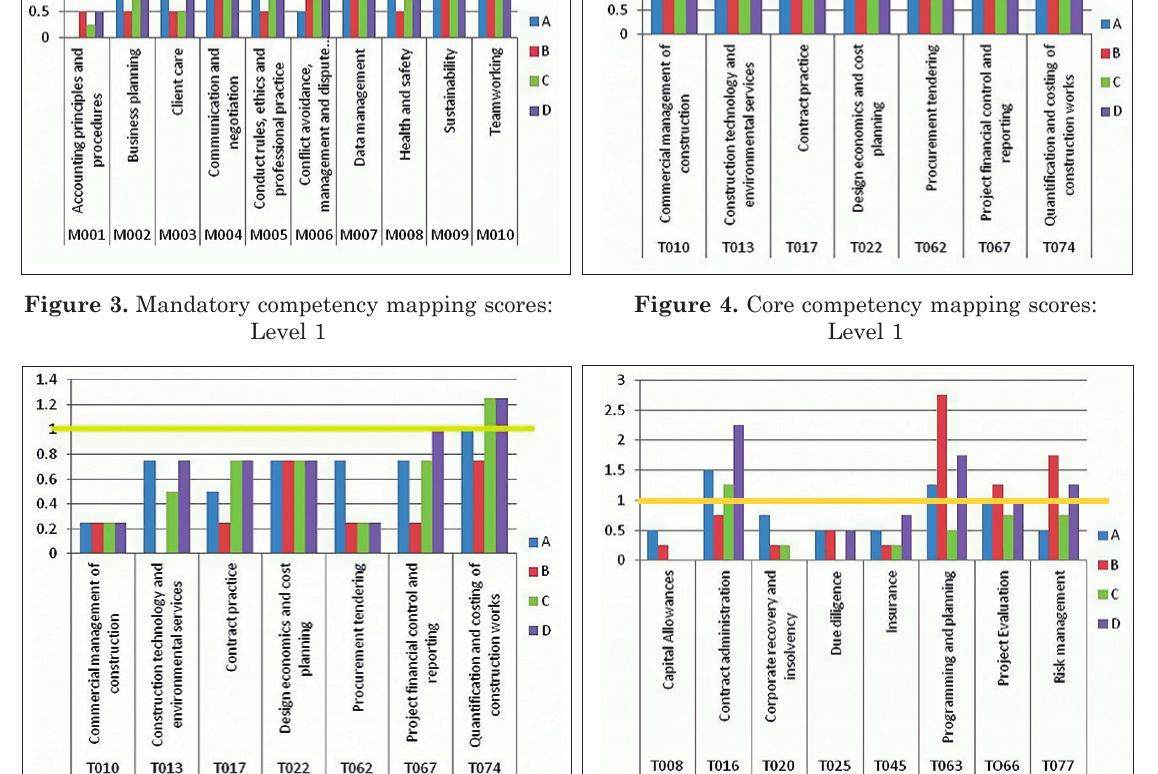
Figure 5. Core competency mapping scores: Level 2 indicates the core competency coverage at Level 2. It is clear that set against a bench-